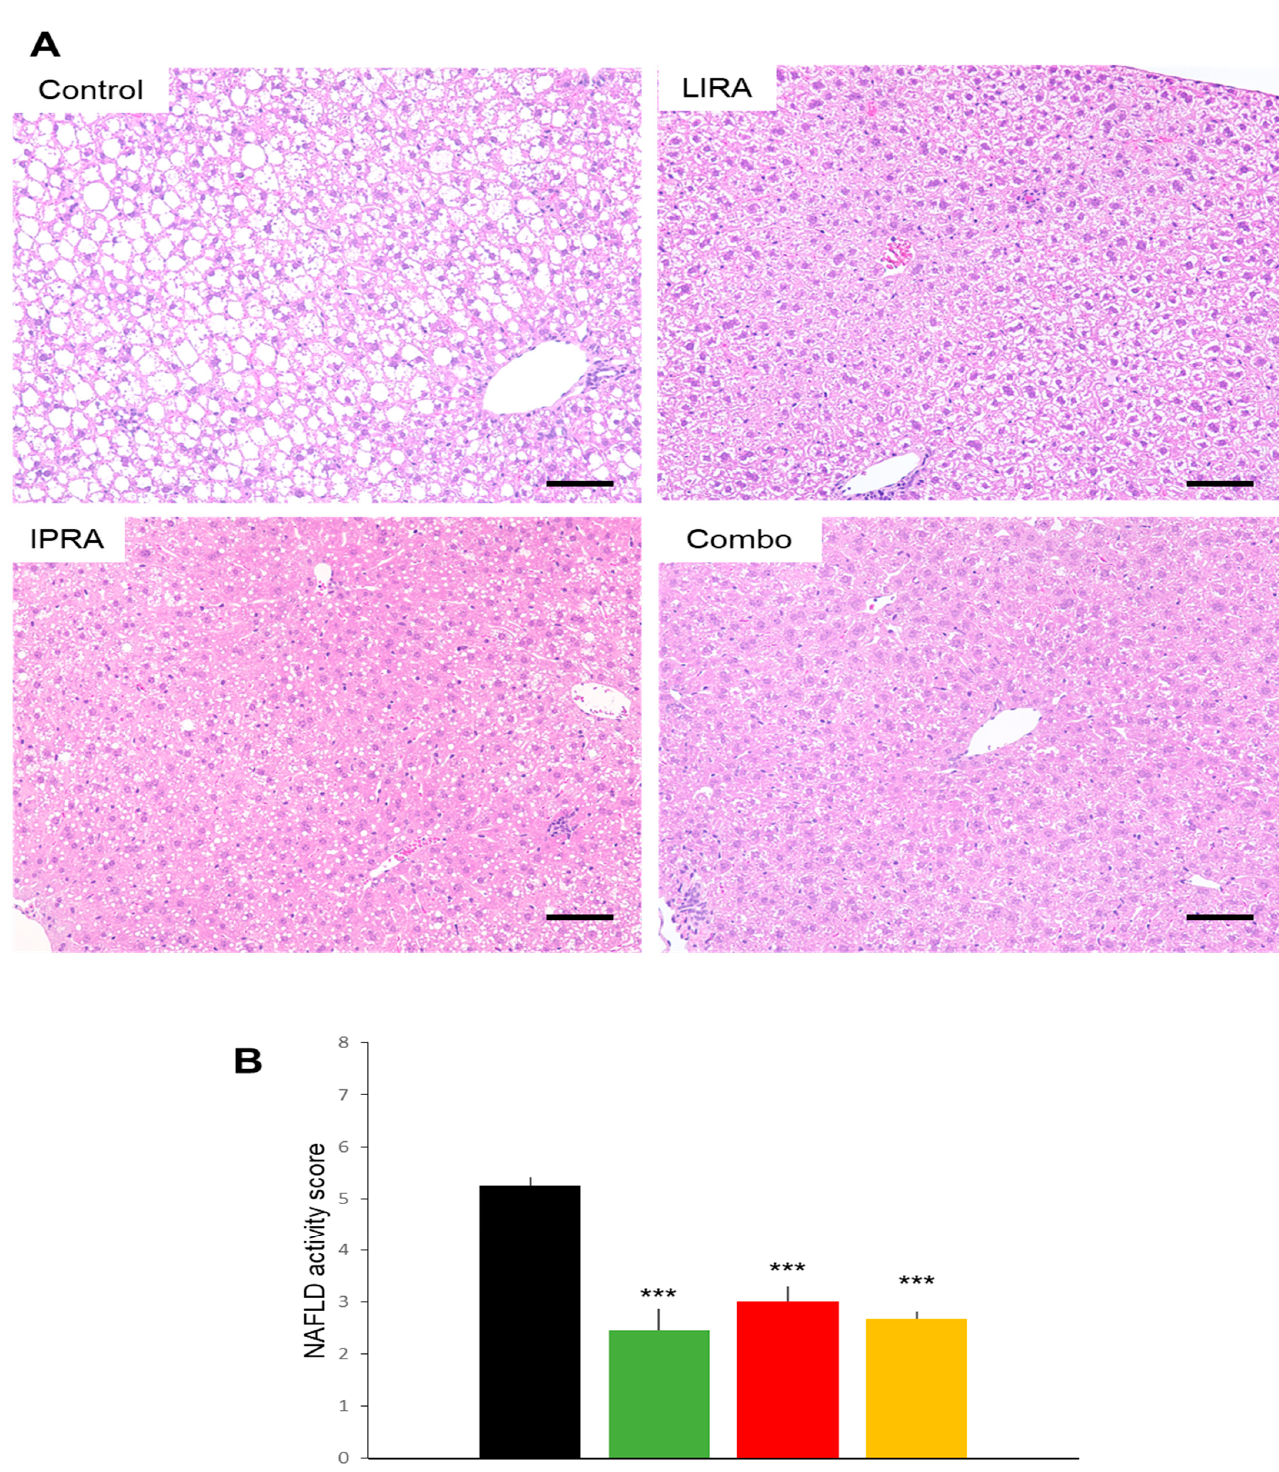
Figure 3. Effects of treatments with liraglutide and/or ipragliflozin on livers in DIO mice. Representative liver sections ( A ) and NAFLD activity score ( B ) of vehicle-treated DIO mice and DIO mice treated with liraglutide and/or ipragliflozin. Data represent mean ± SE, n = 6, *** p < 0.001 vs. Control. Scale bars = 200 μ m.